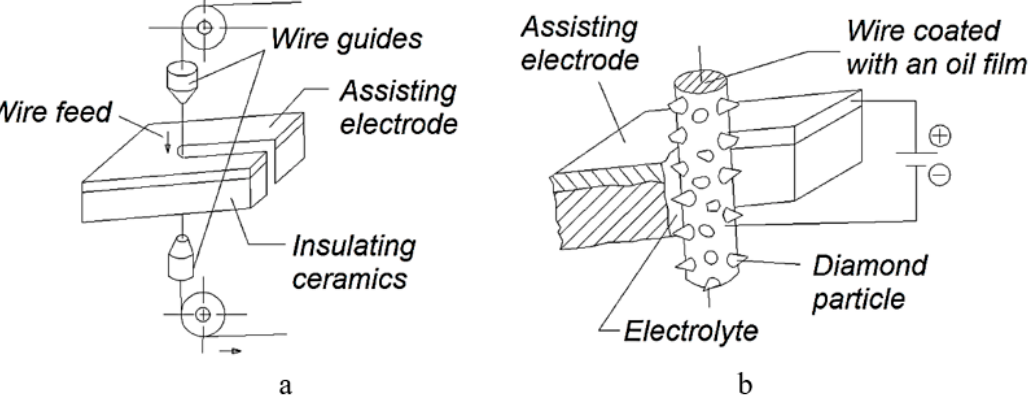
Figure 6. Redrawn figure concerning the assisting electrode use in the wire electrochemical discharge machining: ( a )—simple version; and ( b )—electrochemical discharge-assisted diamond wire cutting [61,62].